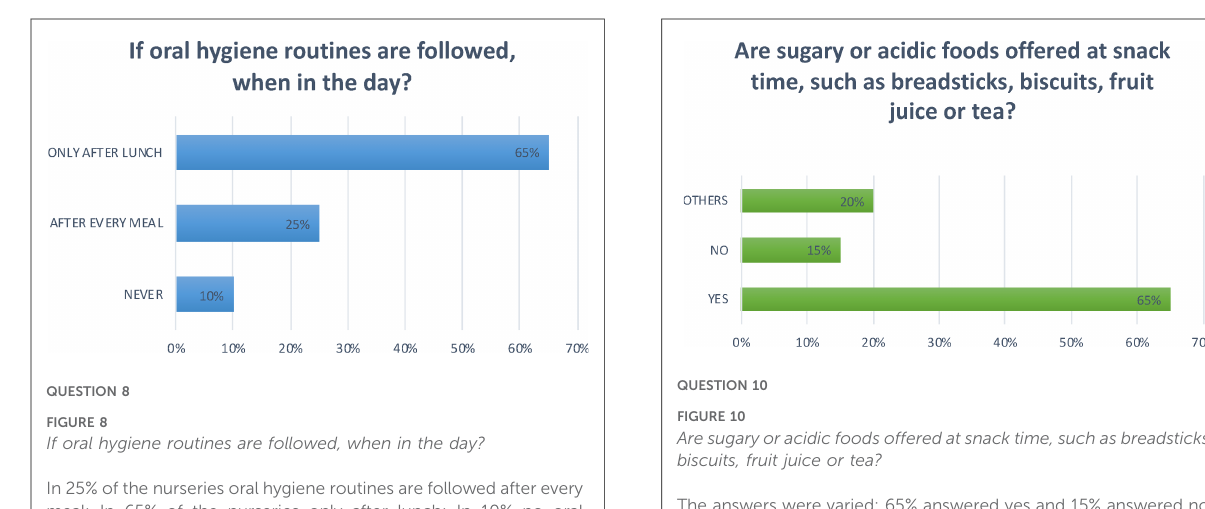
FIGURE 10 Are sugary or acidic foods offered at snack time, such as breadsticks,